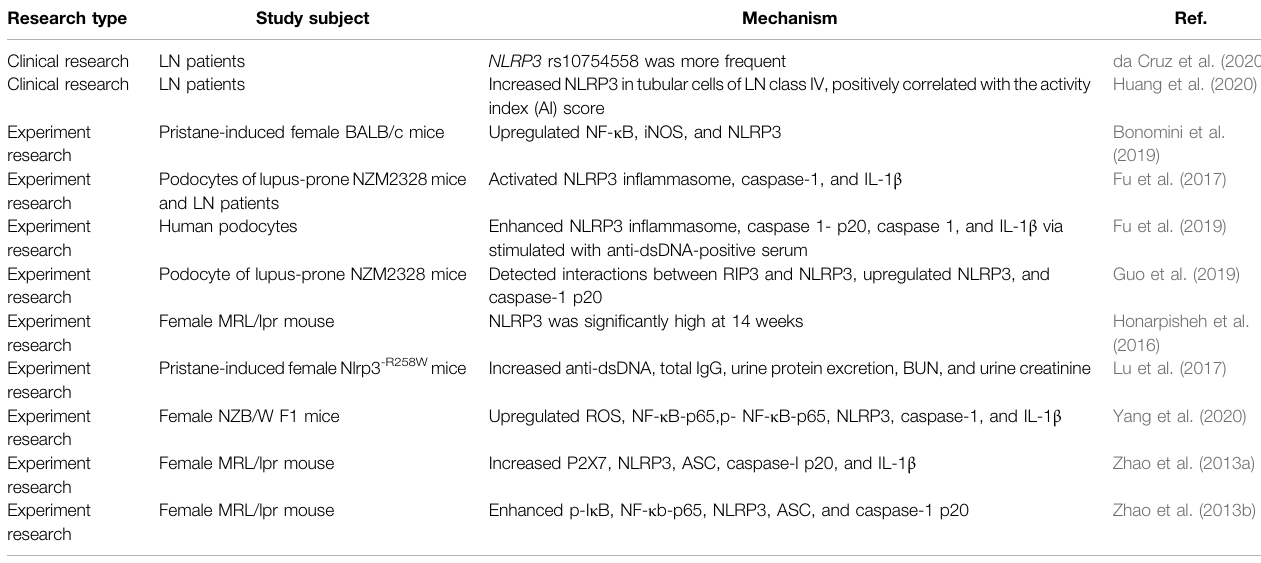
TABLE 1 | Researches on NLRP3 in fl ammasome in lupus nephritis (LN).